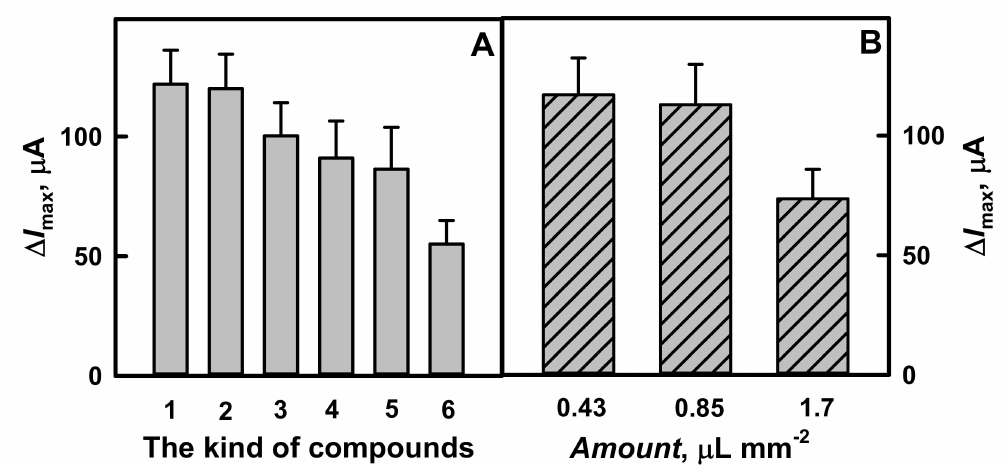
Figure 4. The diagrams of amperometric current response registered using GR electrodes (surface area 0.071 cm 2 ) modified by: ( A ) different kind of compounds and ( B ) different amount of PANI-AuNPs (6 nm) -GOx nanocomposites. Conditions: ( A ) GR/Ppy-AuNPs (6 nm) -GOx/GOx (1 column), GR/PANI-AuNPs (6 nm) -GOx/GOx (2 column), GR/Ppy-GOx/GOx (3 column), GR/PANI-GOx/GOx (4 column) electrodes; ( B ) GR/PANI-AuNPs (6 nm) -GOx/GOx electrode. For comparison, GR/AuNPs (6 nm) -GOx (5 column) and GR/GOx (6 column) electrodes were used. Amperometric responses were registered in 0.05 mol L − 1 SA buffer, pH 6.0, with 0.01 mol L − 1 KCl and 6.0 mmol L − 1